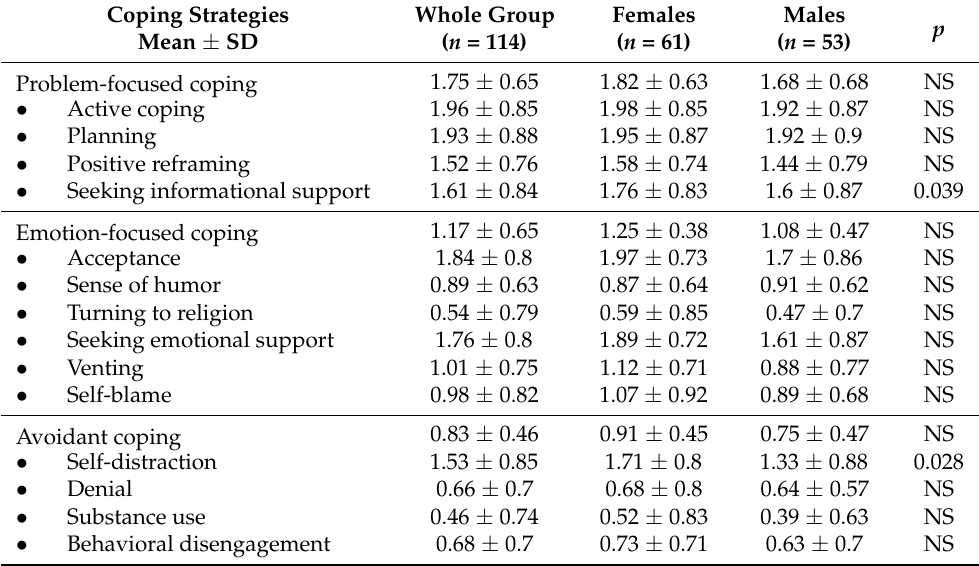
Table 4. Differences in coping strategies among patients with hidradenitis suppurativa. Coping Strategies Mean ± SD